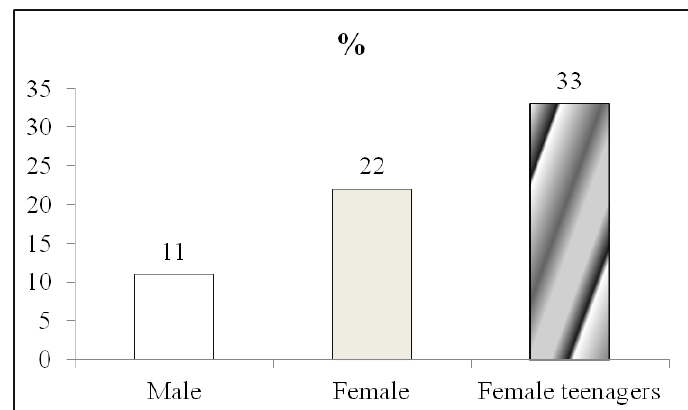
Figure 1. The percentage of injuries related to sex and category of